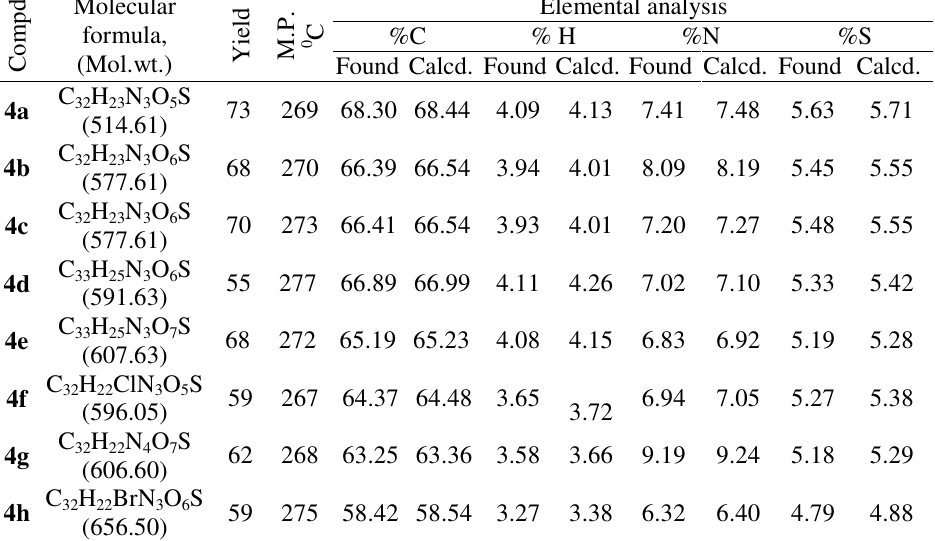
Table 3. Analytical data and elemental analysis of compounds